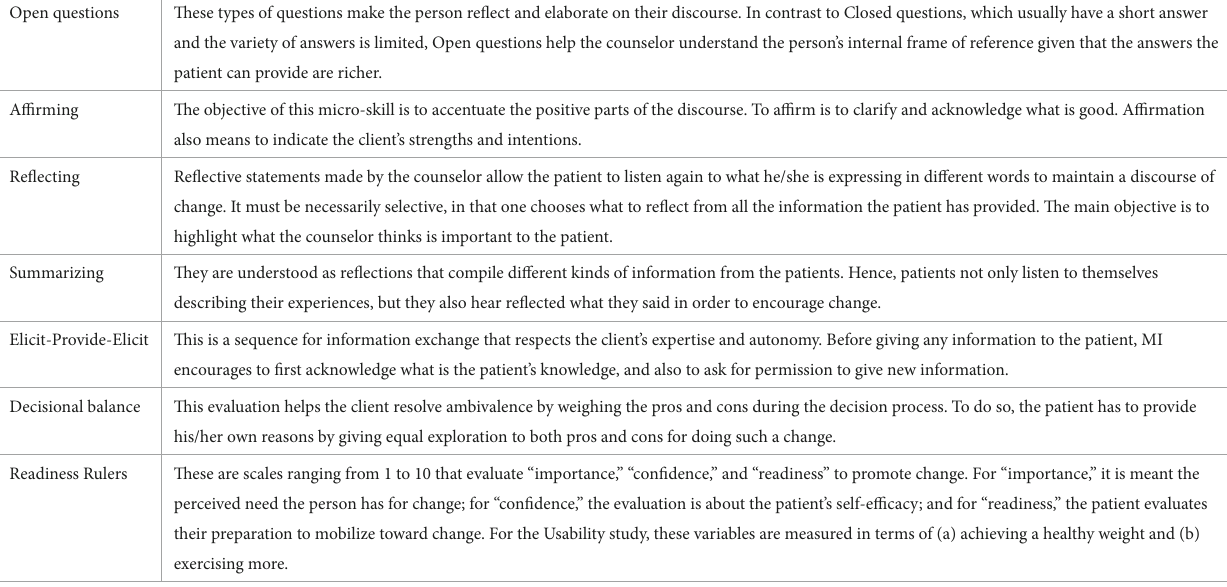
TABLE 1 Summary of the motivational interviewing micro-skills to elicit behavioral change 1